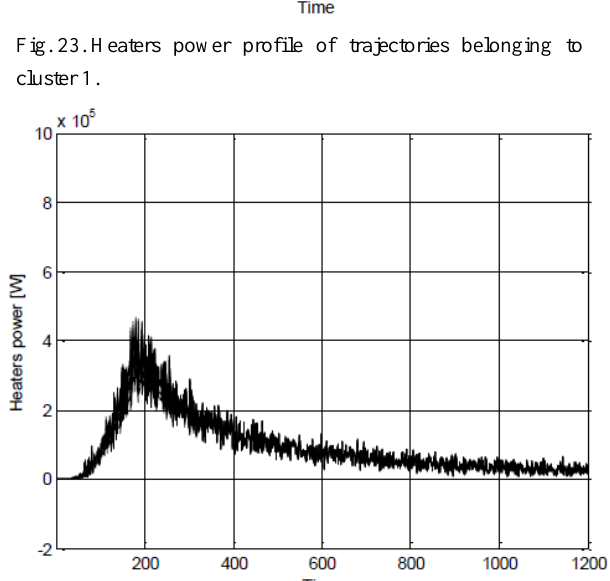
Fig. 23. Heaters power profile of trajectories belonging to cluster 1.